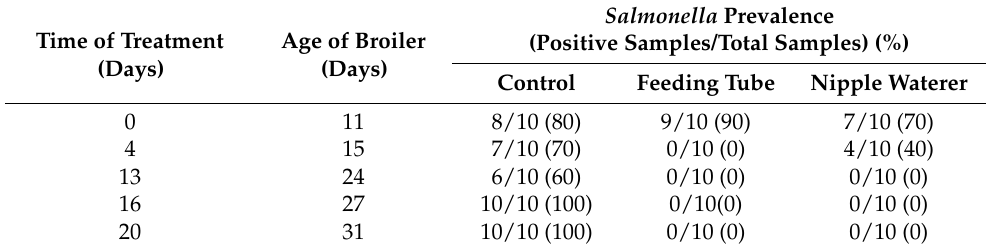
Table 6. Salmonella prevalence in cloacal swab sample of